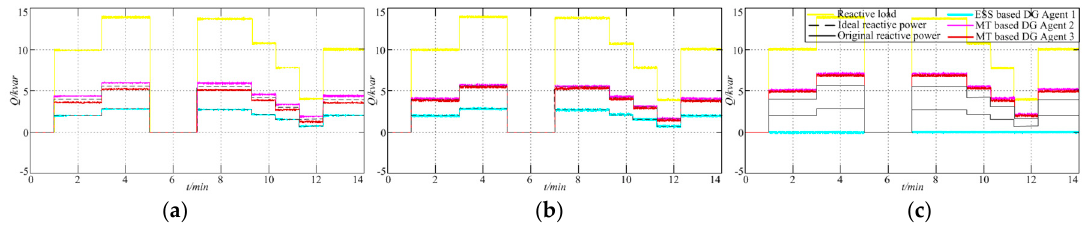
Figure 9. Active power outputs of DGs when secondary control of DG 3 failure. Figure 10. Reactive power outputs of DGs. ( a ) Before applying Q sharing; ( b ) After applying Q sharing; ( c ) DG 1 secondary control failure.